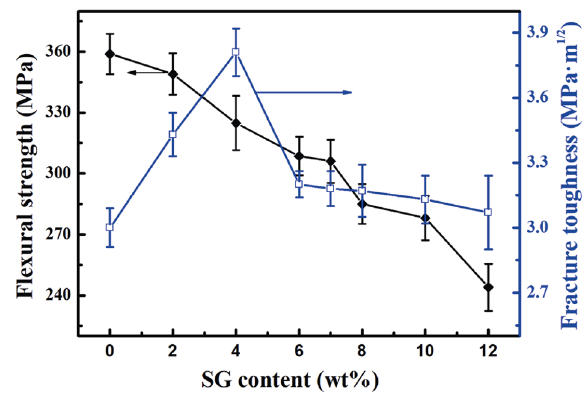
Fig. 9 Mechanical properties of SG/AlN composites with different SG contents.